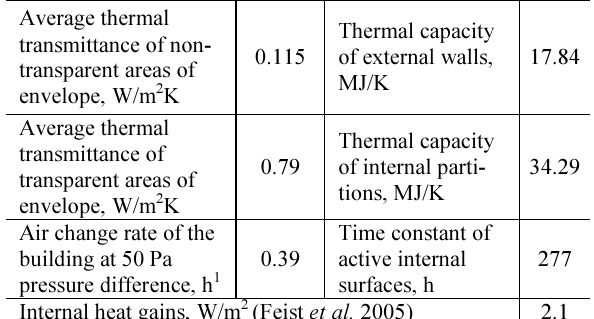
Fig. 1. Medium-cold days and period with the least solar